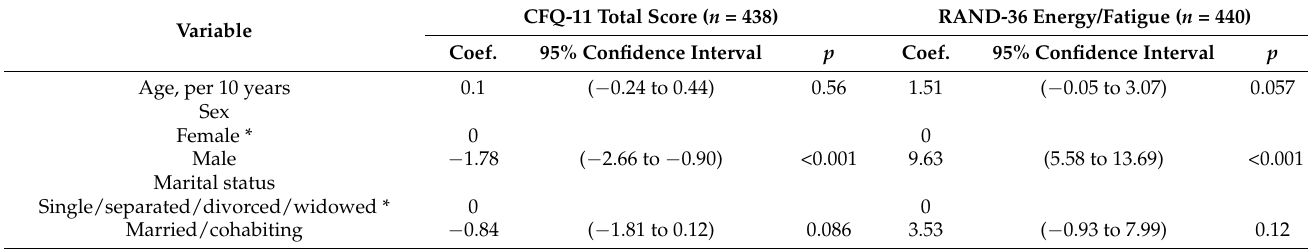
Table 3. Determinants of fatigue scores, (1) CFQ-11 total score (0–33 scale) a and (2) RAND-36 energy/fatigue scale score (0–100 scale) b , multiple linear regression